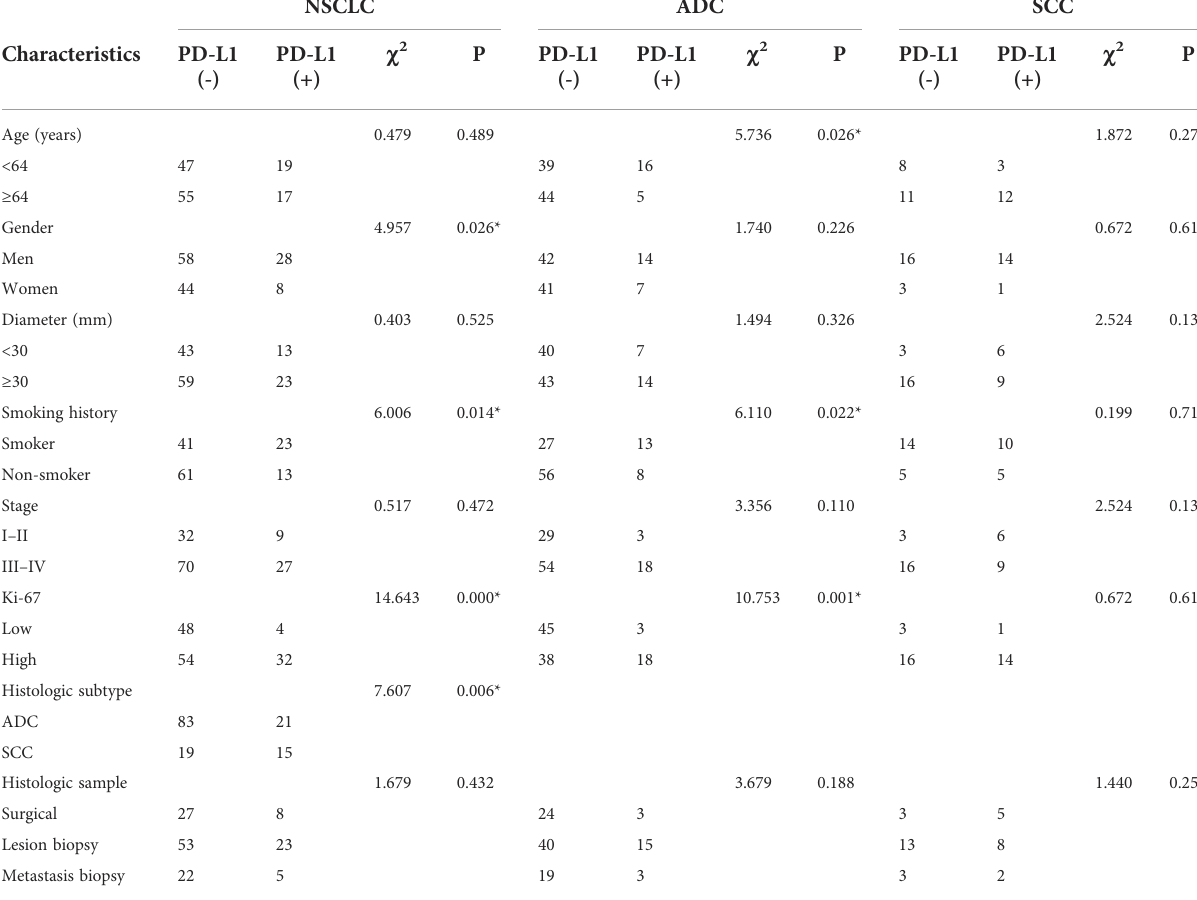
TABLE 1 Characteristics of the PD-L1